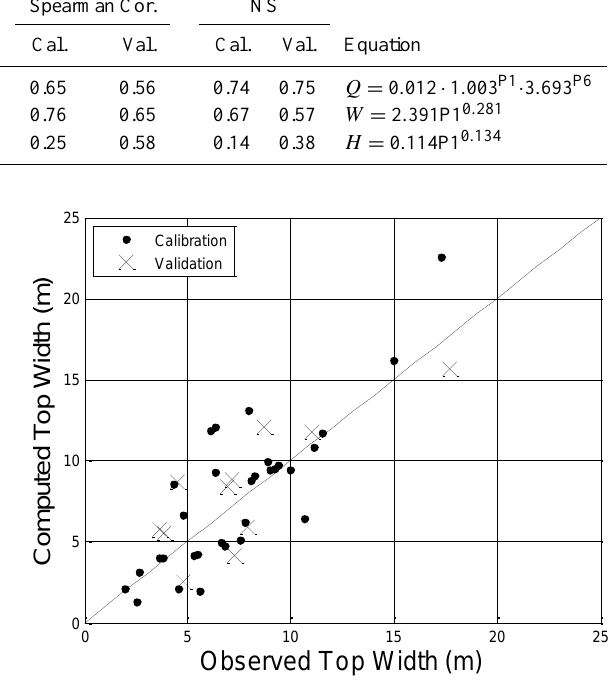
Figure 8. Observed versus computed top width values for the calibration and validation datasets. Fig. 8. Observed versus computed top width values for the calibra- The 1:1 line is shown. tion and validation datasets. The 1:1 line is